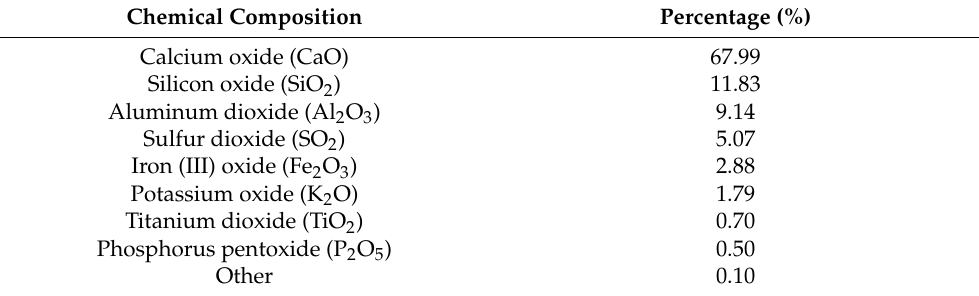
Table 1. Composition of early-strength cement.